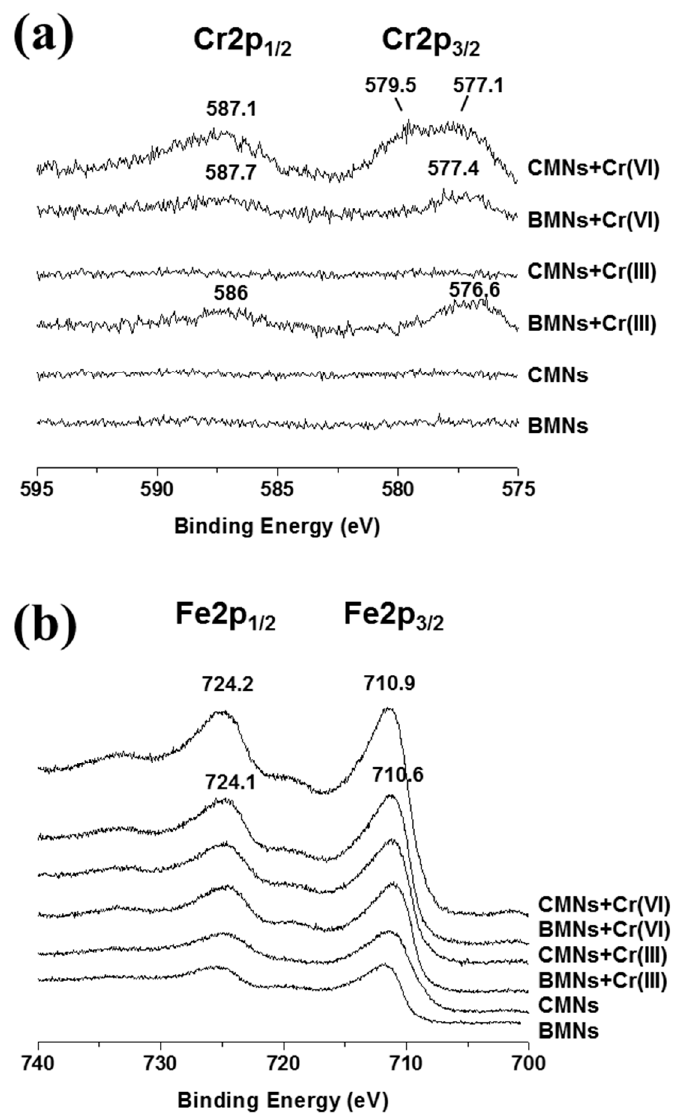
Figure 4. ( a ) Cr 2p and ( b ) Fe 2p XPS spectra of CMNs and BMNs reacted Cr(III/VI).